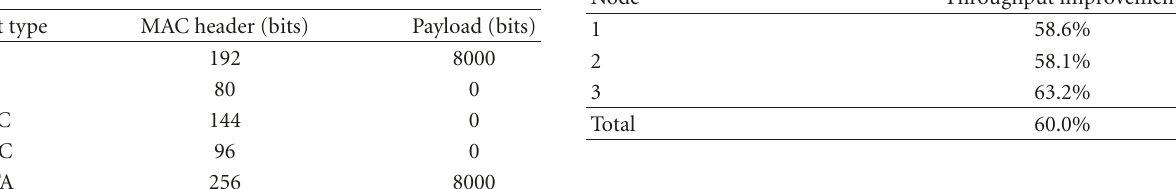
Figure 8: Matlab linear program gain results. Top: neglecting overhead, Bottom: including overhead. Table 2: Packet lengths. All packets include 192 bit PLCP preamble and header, 32 bit FCS, and variable MAC header sent at 1Mbps. Payload bit rates are variable.